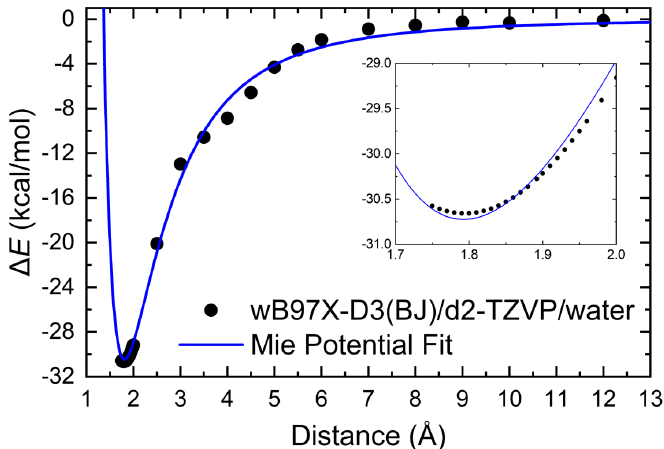
Figure 9. Interaction energy of BUD with CS that has fully protonated amino groups. The inset enlarges the region at the bottom of the energy well. The blue line is a fit of the computed data points to a Mie potential (see main text). Datapoints (solid circles) were computed at the ω B97X-D3(BJ)/def2- TZVP/PCM level of theory.